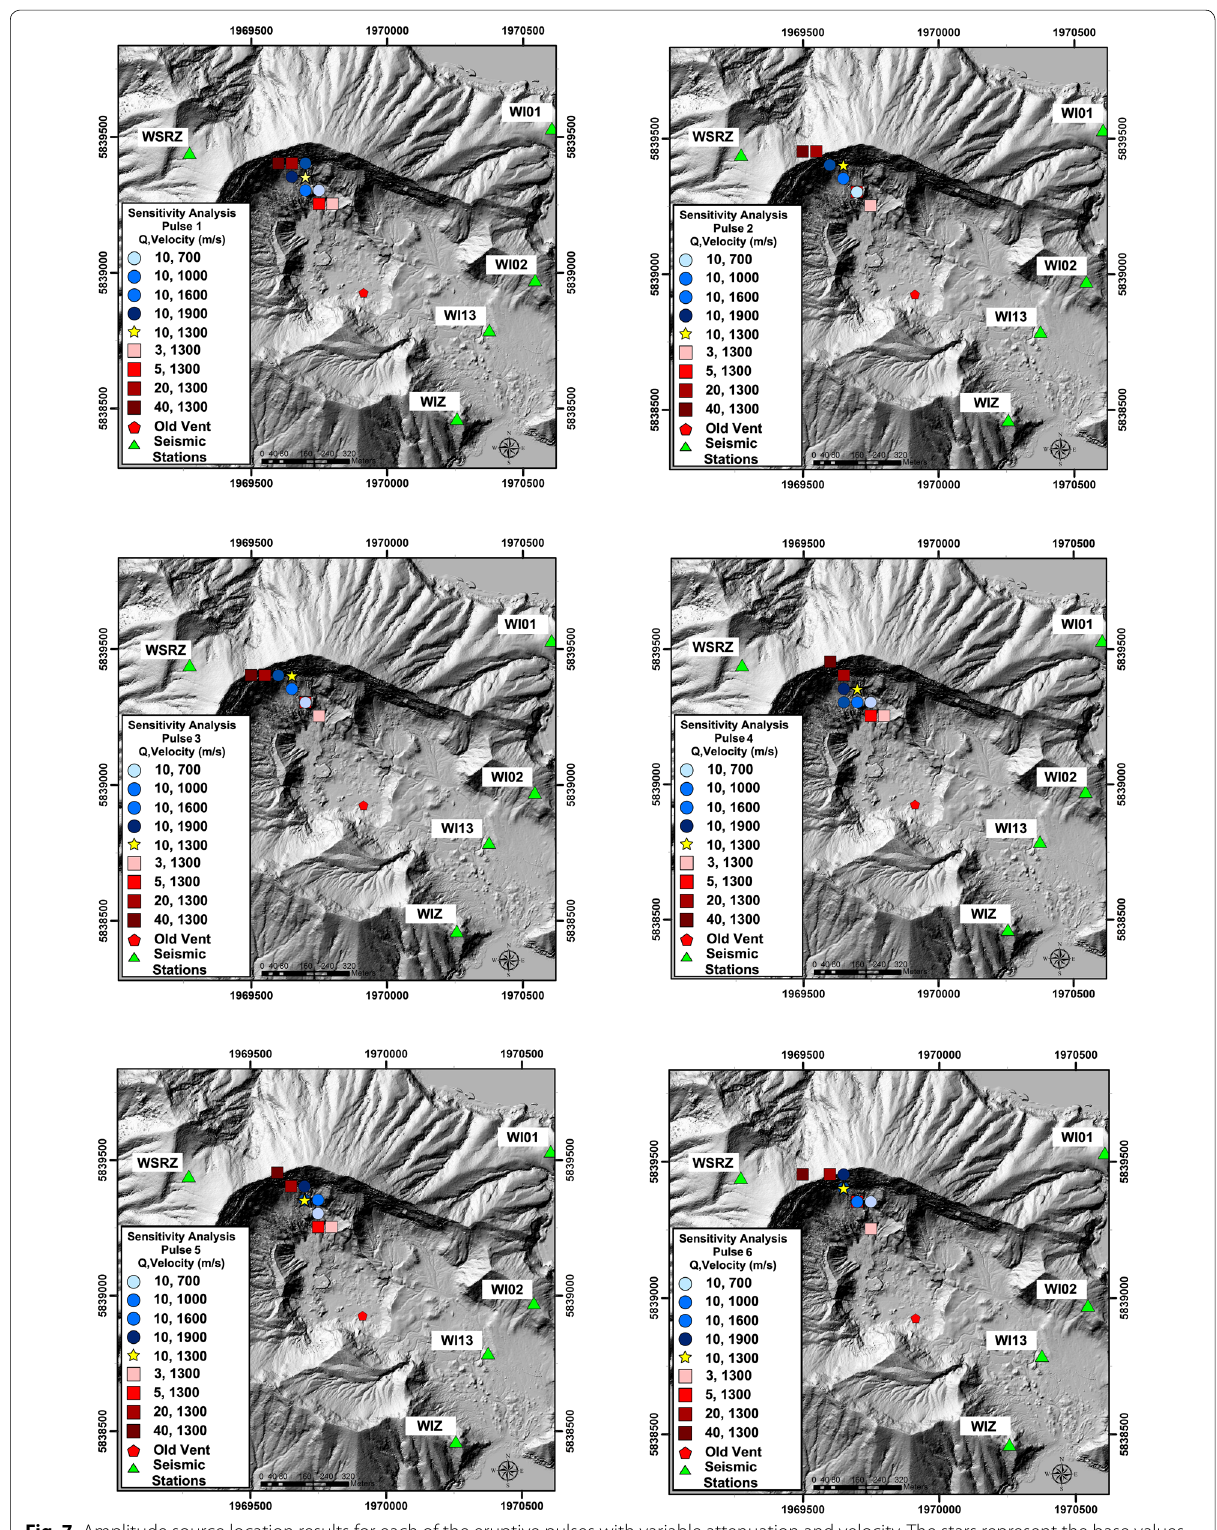
Fig. 7 Amplitude source location results for each of the eruptive pulses with variable attenuation and velocity. The stars represent the base values of a Q 10 and a body wave velocity of β 1300 m/s, while the changing attenuation values are represented as squares and the velocity as = =